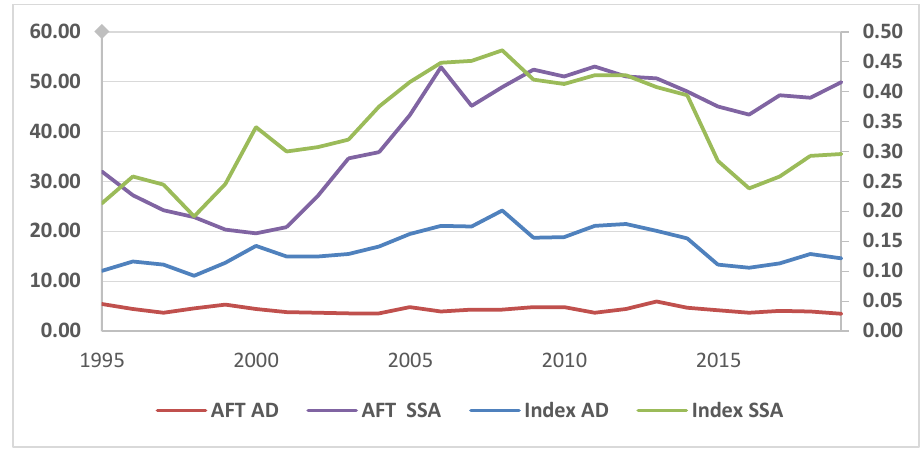
Figure 1: Aid trend and the diversification index (AD= Developing Asia; SSA=South Saharan Africa) ; Source: UNCTA and WDI